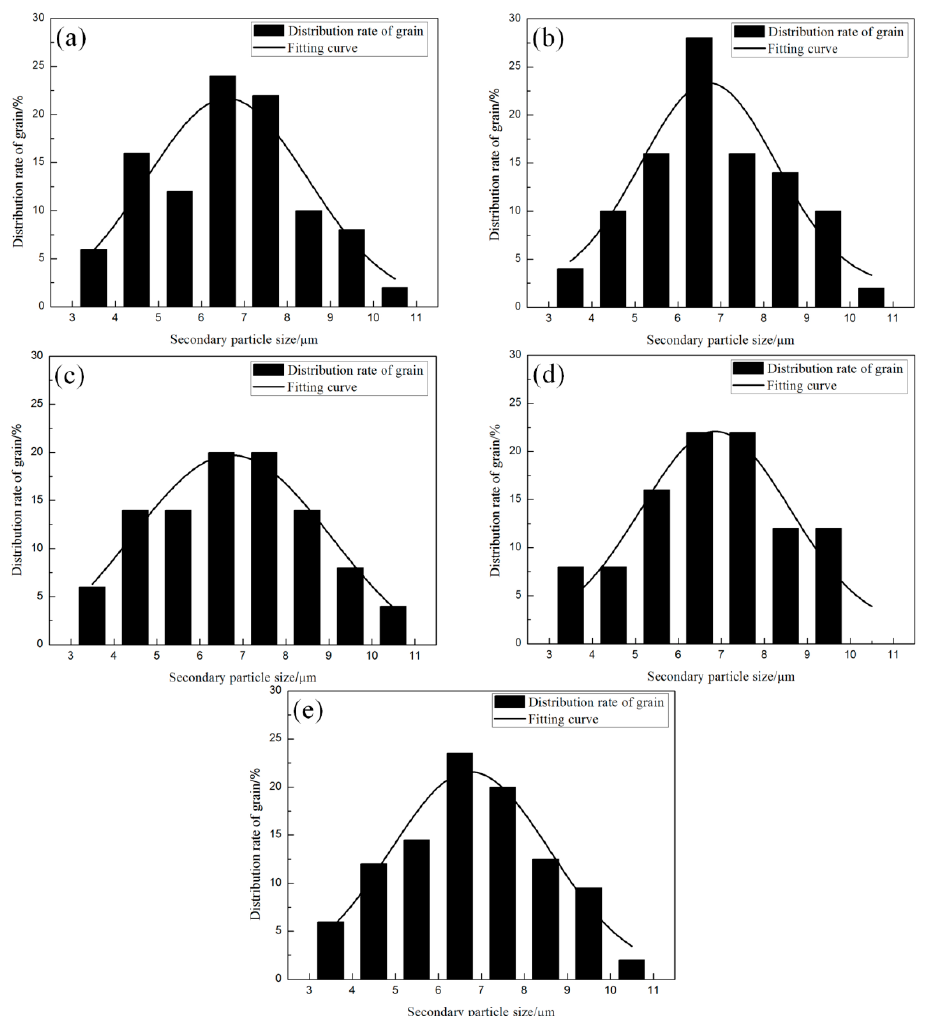
Figure 6. The distribution of the secondary particle size in thin-walled die-casting ( a ) 0 min, ( b ) 3 min, ( c ) 5 min, ( d ) 10 min, and ( e ) the total distribution.